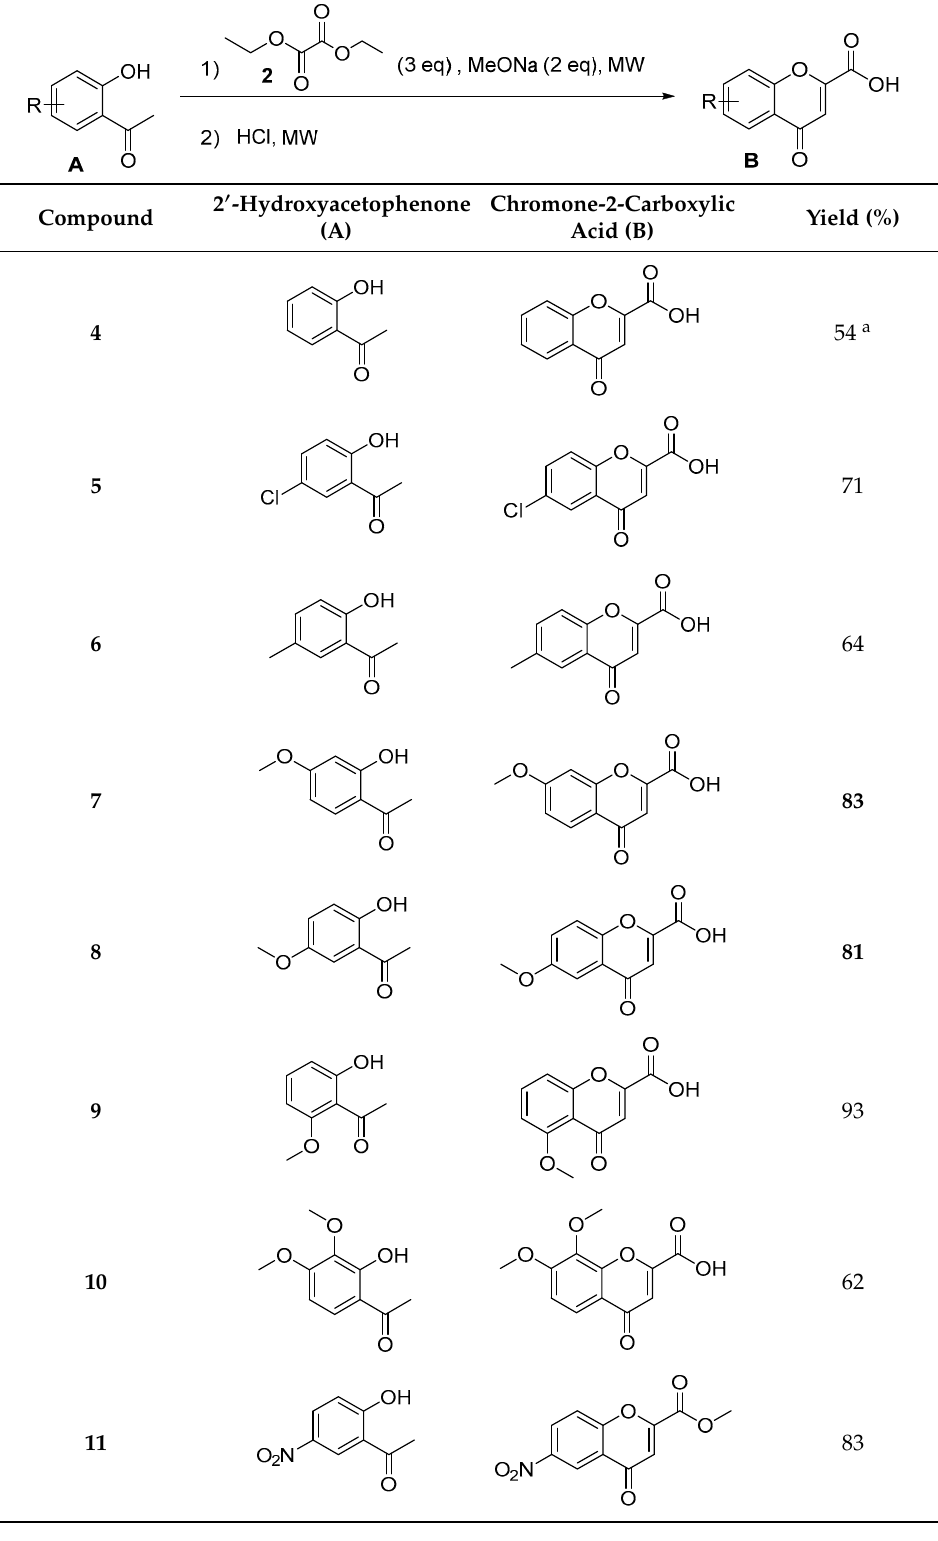
Table 2. Synthesis of chromone-2-carboxylic acids by microwave-assisted reaction.